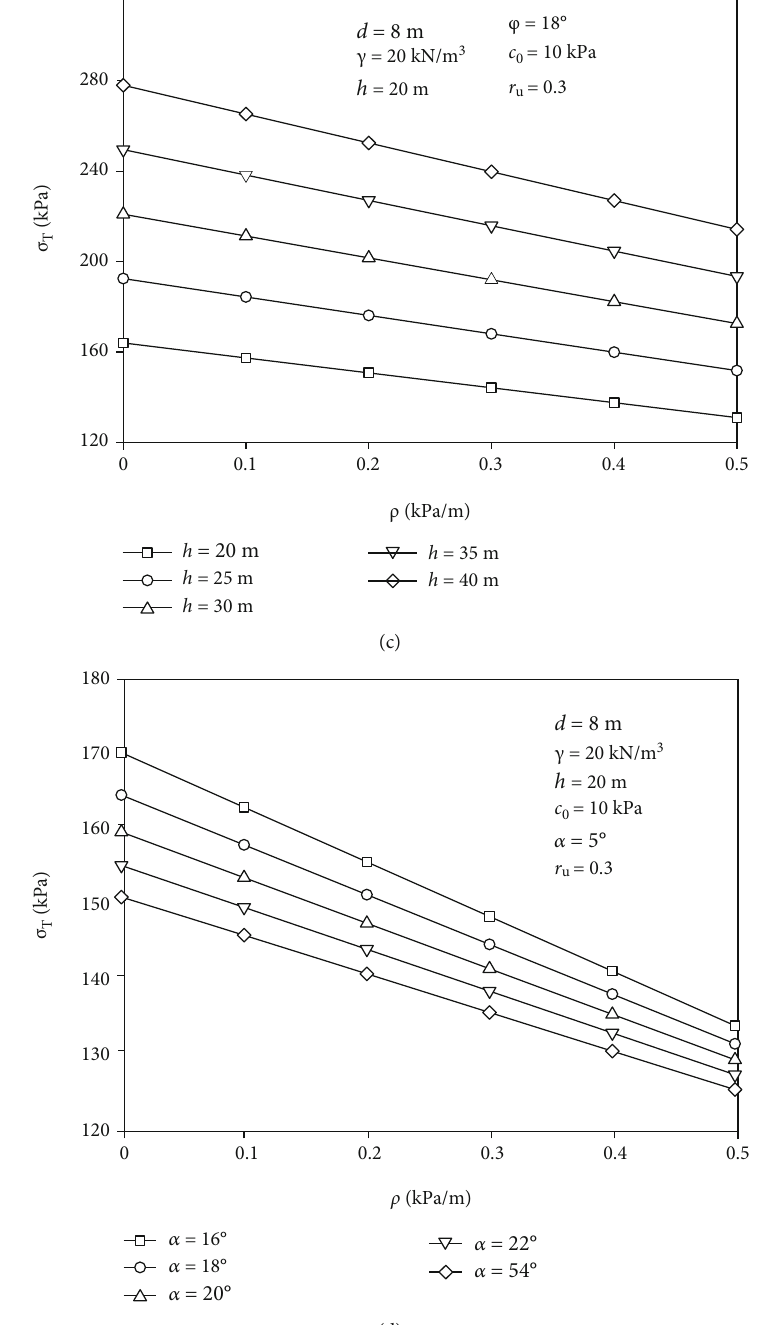
0 ; (c) buried depth h ;